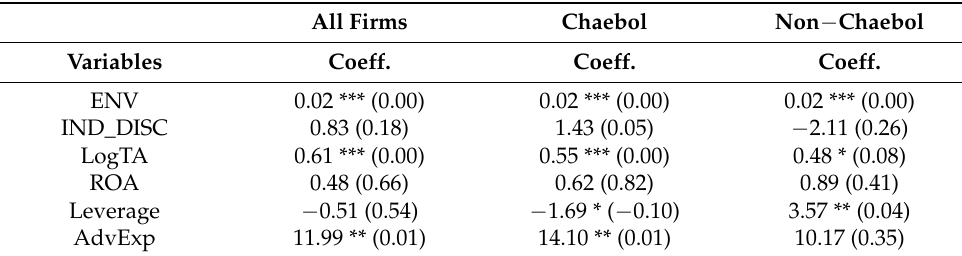
Table 7. Firm-value effects of decision to disclose carbon emission (H-2). All Firms Chaebol Non − Chaebol Variables Coeff. Coeff.